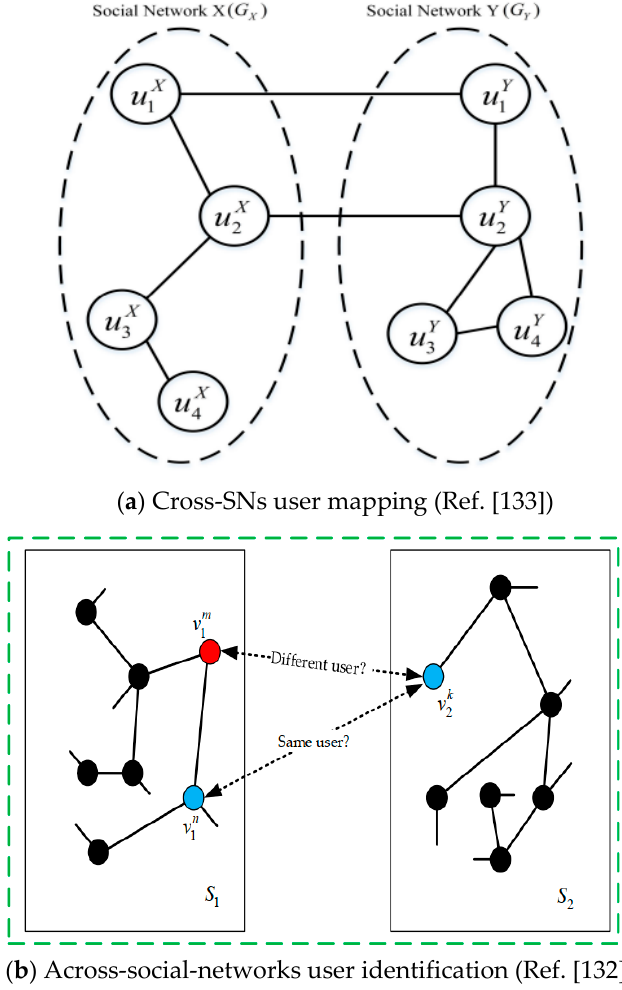
Figure 35. Overview of the users mapping and identification across SNs (i.e., multiple SNs).